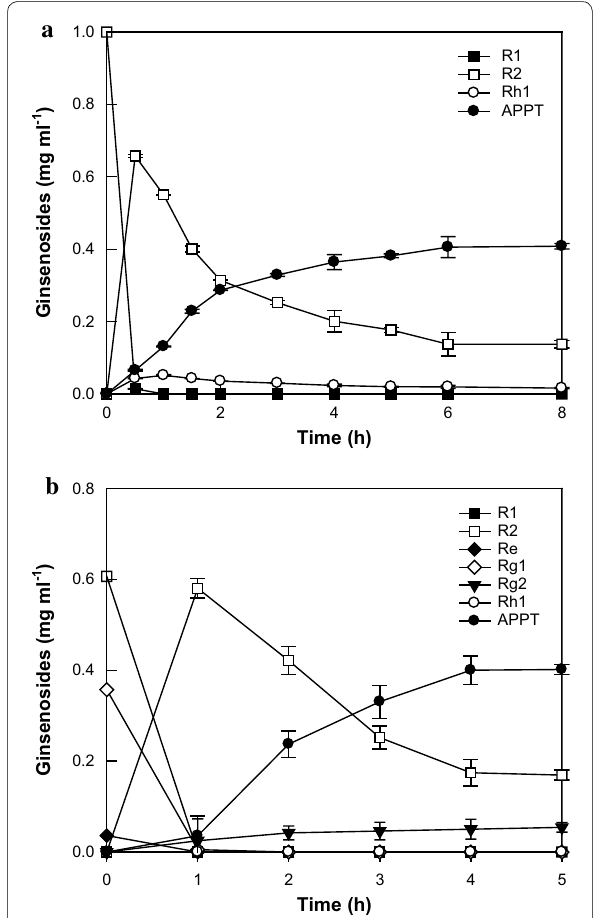
tional file 1: Figure S2b). APPT production was maximal at 1.0 mg ml − 1 total PPT-type ginsenosides in notogin-